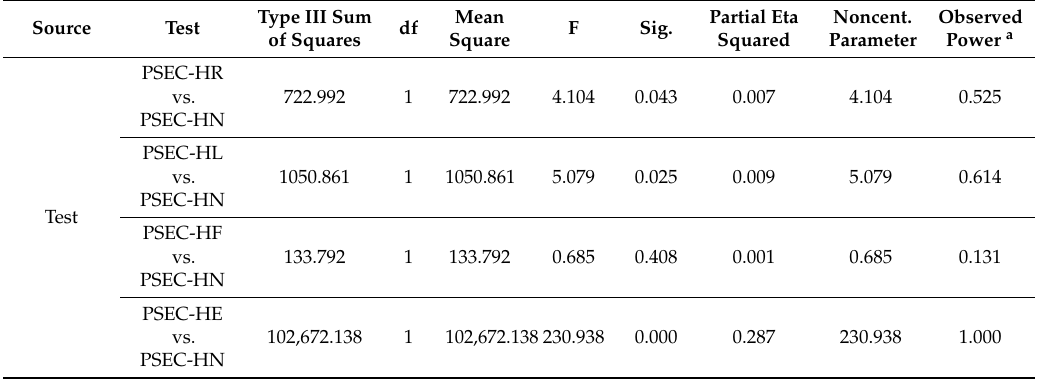
Table 11. Tests of within-Subjects Contrasts for Concussion Patients’ Postural Stability Scores with Head